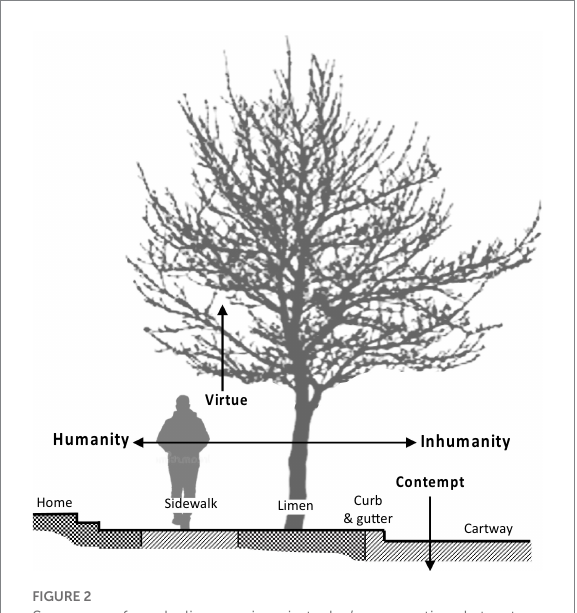
FIGURE 2 Summary of symbolic meanings in today’s conventional streets and street